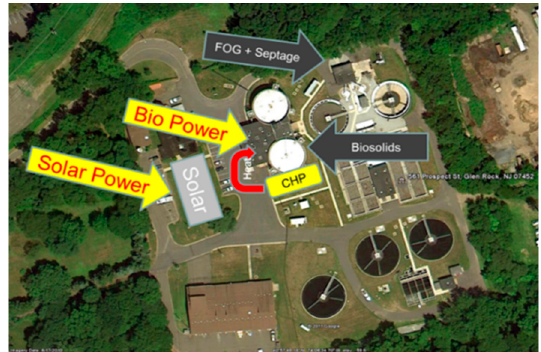
Figure 3. Ridgewood wastewater treatment plant [31].